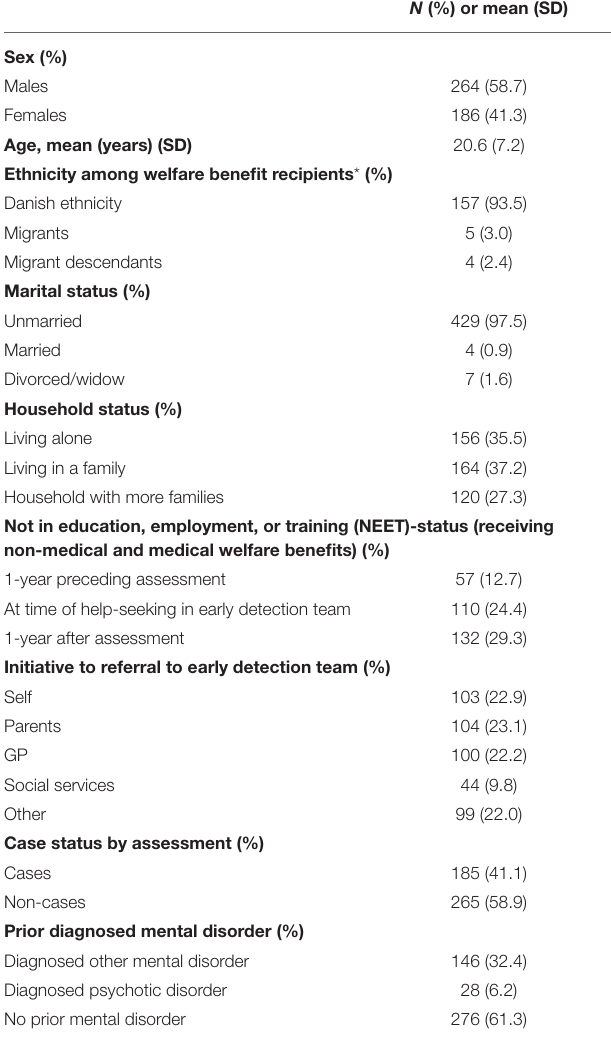
TABLE 1 | Study population characteristics ( n = 450